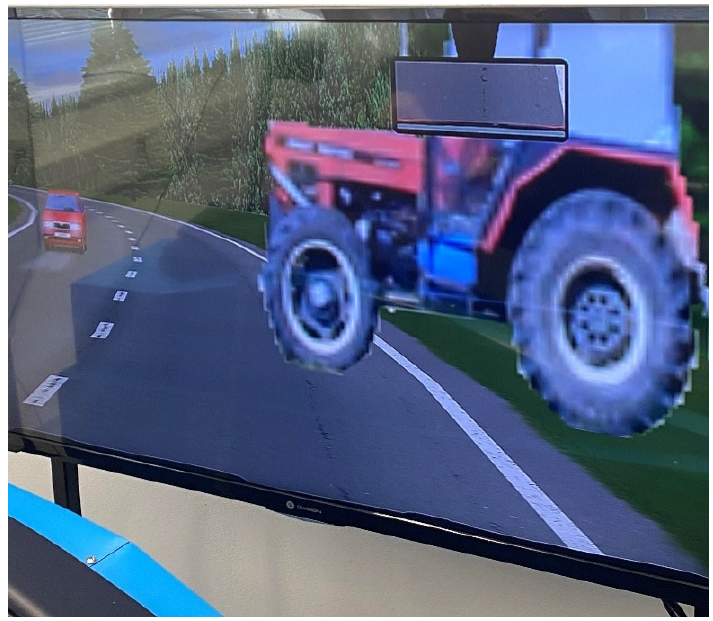
Figure 2. Simulator with an obstacle on the screen. Source: own collaboration. The last part of study design explains how different obstacles appeared on the screen before driver reaction was needed. After drivers were acquainted with the simulator and all its elements, the risk environment was launched. Drivers always started from the same beginning point and their first task was to increase the speed to 50 km/h. They were informed about various obstacles crossing, falling onto, or entering the road before they started the journey. When they observed an obstacle on the screen, their immediate response should follow by pressing the brake pedal. It is necessary to clearly indicate that the obstacle may appear in the image gradually and not suddenly. As is shown in Figure 3, the obstacle could be a tree falling down at the right side part of the screen but a similar situation was also happening at the left side. Naturally, with increasing the speed of the vehicle, driver response time to observe the obstacle appeared on the screen was shorter. If the driver’s response was too slow, then a crash with the obstacle